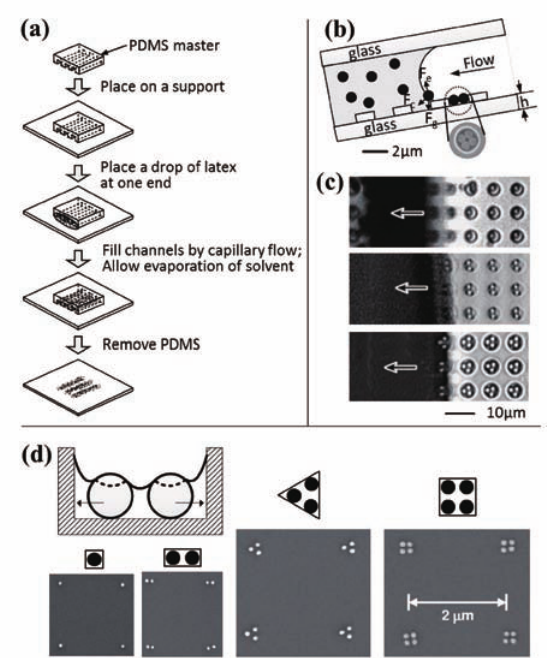
Fig. 2 (a) A schematic illustration for the process of micromolding in capillaries. Reprinted with per- mission from ref 60. Copyright 1996 VCH. (b) A schematic illustration of the process to gener- ate aggregates of spherical colloids under the physical confinement of templates. A colloidal particle next to the rear edge of the liquid slug experiences three possible forces there: the capillary force (Fc), the gravitational force (Fg), and the electrostatic force (Fe). (c) Optical mi- crographs showing the assembly of polystyrene beads with different sizes into cylindrical holes with different sizes. (b) and (c) are reprinted with permission from ref 65. Copyright 2003 Willey-VCH. (d) A schematic illustration of the particle separation due to the probable free sur- face of the liquid in a pattern and the experimen- tal results of the assembly of particles which are preferably positioned at the corner of each pattern. Reprinted with permission from ref